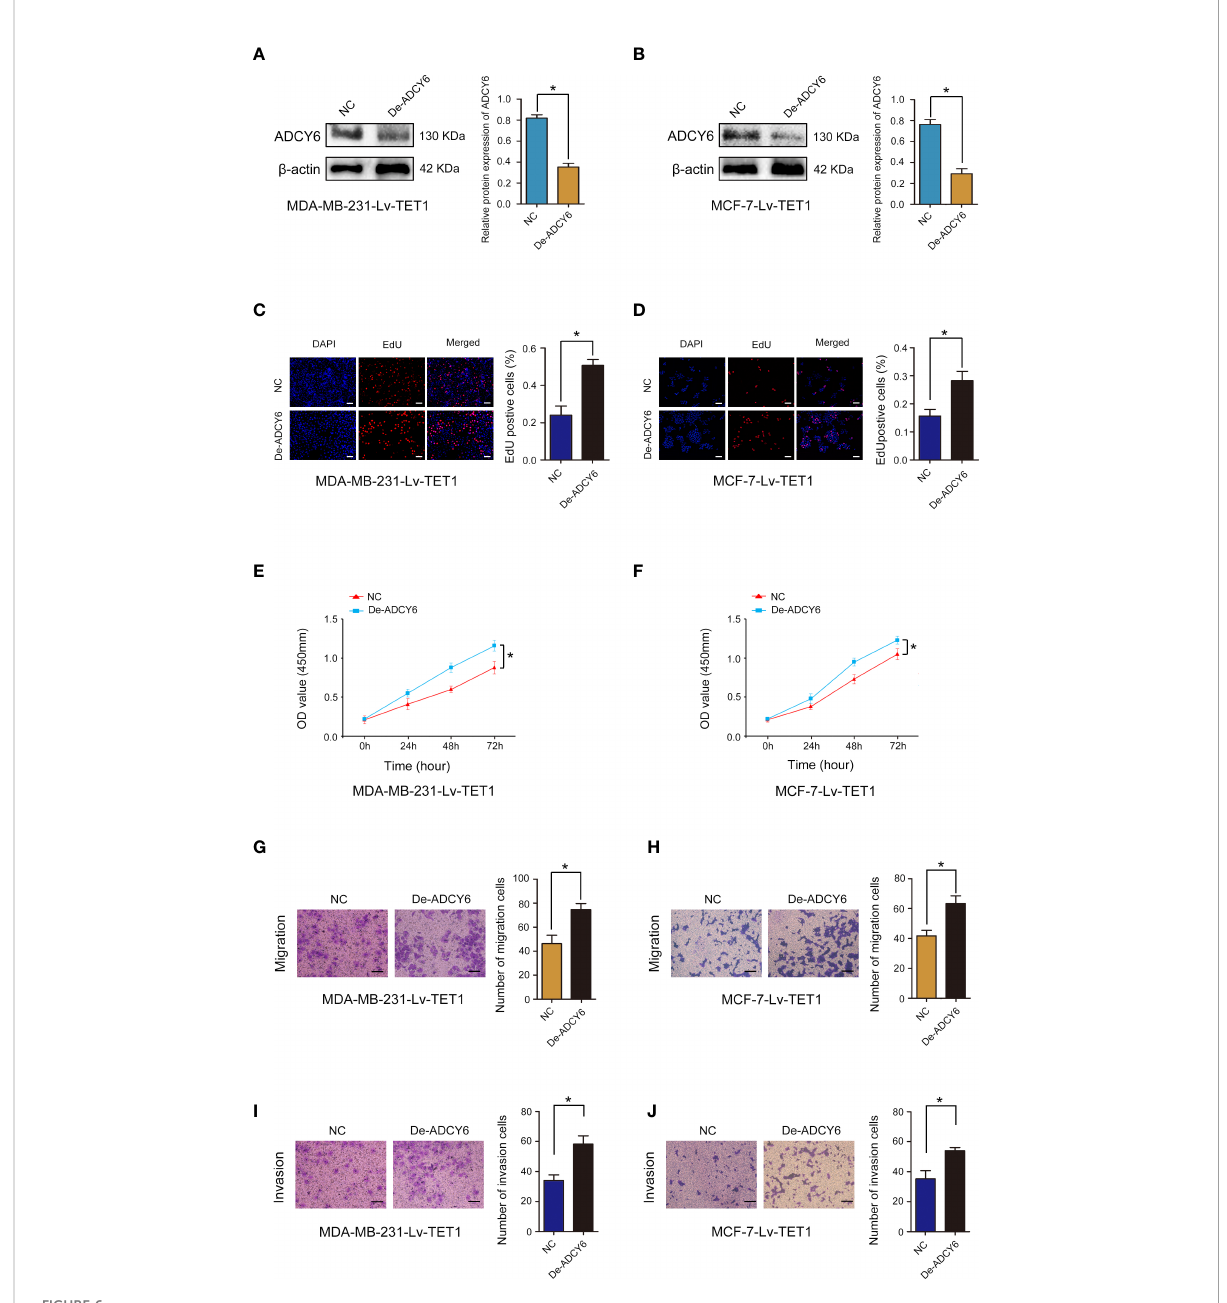
FIGURE 6 Rescue experiments were performed to con fi rm that TET1 ameliorates the inhibitory effect of ADCY6 on BCa progression. (A) The protein expression of ADCY6 after decreasing ADCY6 expression in MDA-MB-231-Lv-TET1. *p < 0.05 versus controls. (B) The protein expression of ADCY6 after decreasing the expression of ADCY6 in MCF-7-Lv-TET1 cells. *p < 0.05 versus controls. (C) The uptake capacity of EdU in MDA- MB-231-Lv-TET1 cells that decreased the expression of ADCY6 was determined by EdU assay. Scale bars, 50 µm. *p < 0.05 versus controls. (D) The uptake capacity of EdU in MCF-7-Lv-TET1 cells that decreased the expression of ADCY6 was determined by EdU assay. Scale bars, 50 µm. *p < 0.05 versus controls. (E) Proliferation of MDA-MB-231-Lv-TET1 cells that decreased the expression of ADCY6 was determined by CCK-8 assay. *p < 0.05 versus controls. (F) Proliferation of MCF-7-Lv-TET1 cells that decreased the expression of ADCY6 was determined by CCK-8 assay. *p < 0.05 versus controls. (G) The migration of MDA-MB-231-Lv-TET1 cells that decreased the expression of ADCY6 was determined by Transwell assay. *p < 0.05 versus controls. (H) The migration of MCF-7-Lv-TET1 cells that decreased the expression of ADCY6 was determined by Transwell assay. *p < 0.05 versus controls. (I) The invasion of MDA-MB-231-Lv-TET1 cells that decreased the expression of ADCY6 was determined by Transwell assay. *p < 0.05 versus controls. (J) The invasion of MCF-7-Lv-TET1 cells that decreased the expression of ADCY6 was determined by transwell assay. *p < 0.05 versus